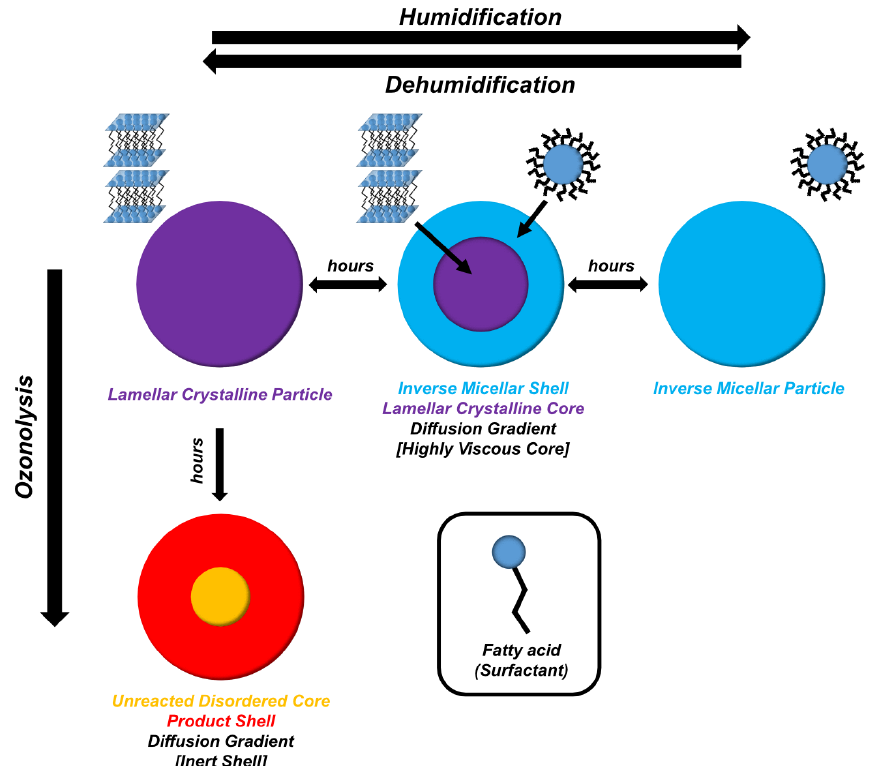
Figure 3. A schematic summarising the findings of this study. Particle humidification–dehumidification and ozonolysis are represented showing core–shell behaviour. Cartoons of SAXS-observed phases are labelled for